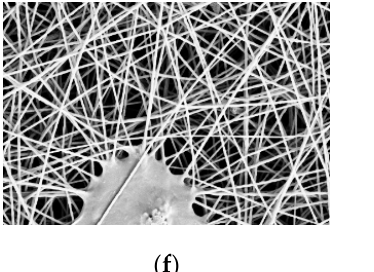
Figure 2. Public Datasets: ( a – e ) are from the public knitting dataset [10]; ( f ) and ( g ) are from the public nano fiber dataset [11]: ( a ) cross piece defect; ( b ) tearing defect; ( c ) broken warp; ( d ) hole; ( e ) broken weft; ( f ) thin film defect; ( g ) cross piece defect.